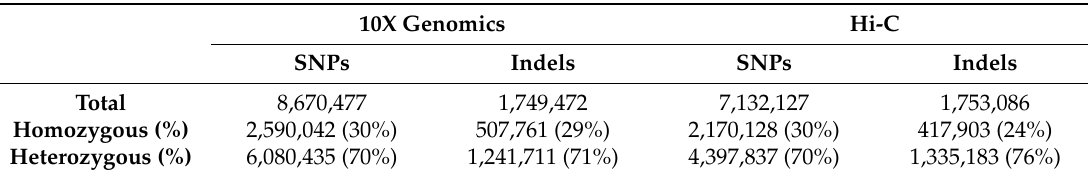
Table 2. Summary of single nucleotide polymorphisms (SNPs) and insertion-deletion polymorphisms (indels) identified in this